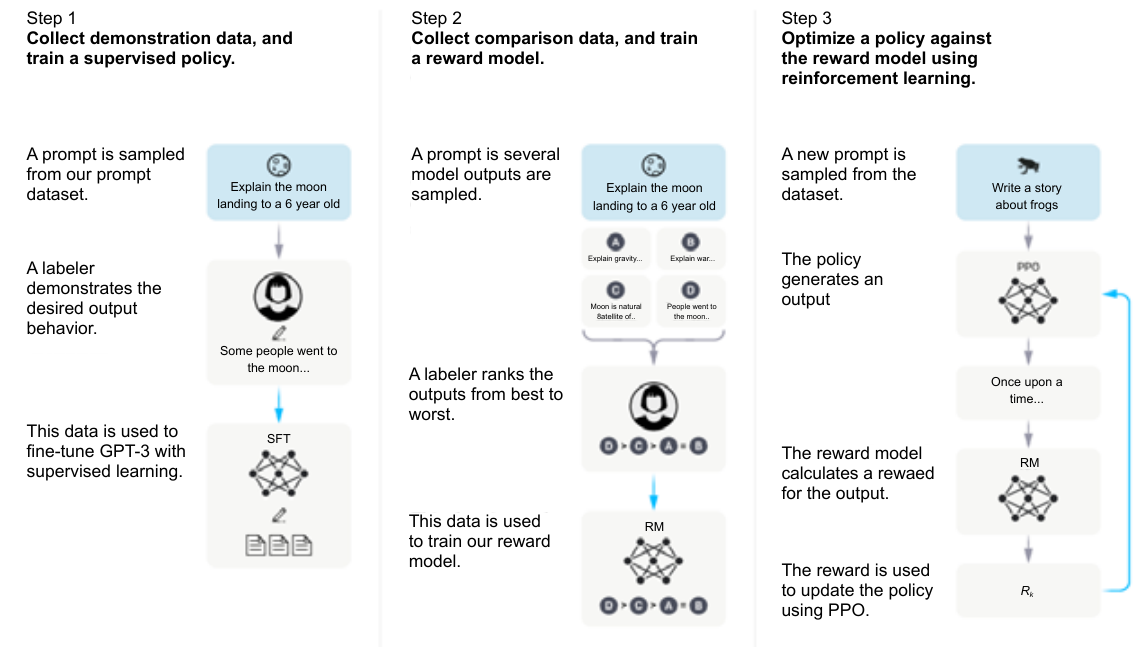
Figure 7 InstructGPT Training Process. The training process of InstrumentGPT consists of three steps [2]. They used a PPO (Proximal Policy Optimization) [22] network to produce outputs. The reward feedback model gives feedback to the PPO network. These steps were repeated until the InstrumentGPT model aligns with human values